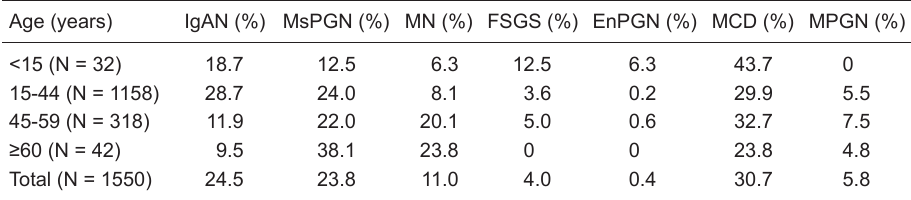
Table 1. Frequency of primary glomerular diseases according to